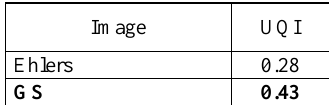
Table 7. Universal Quality Index comparison between the Ehlers and GS fusion method with the GS scoring best.